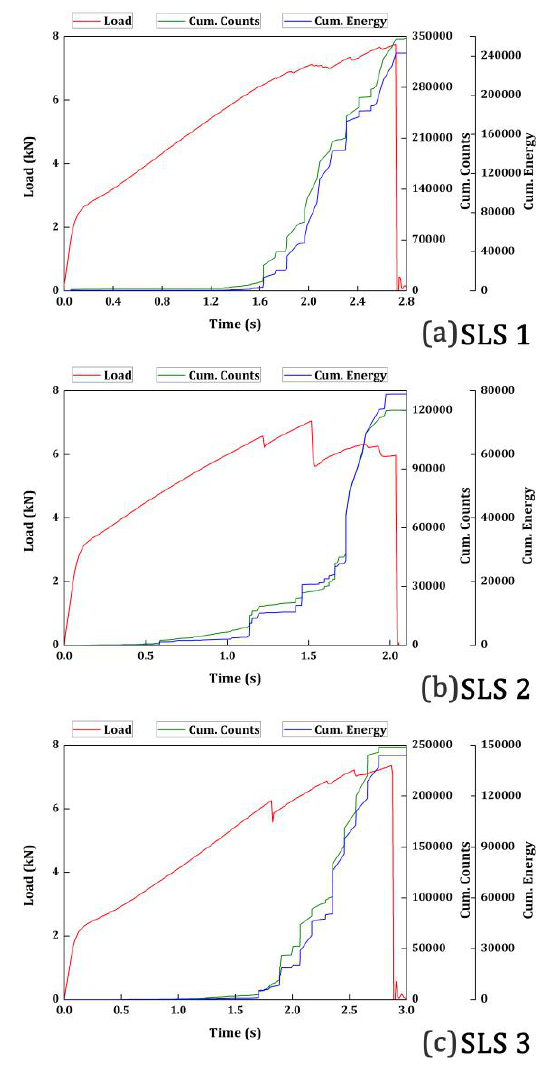
Figure 6. Load, cumulative counts, cumulative energy vs. time: ( a ) SLS 1; ( b ) SLS 2; ( c ) SLS 3.